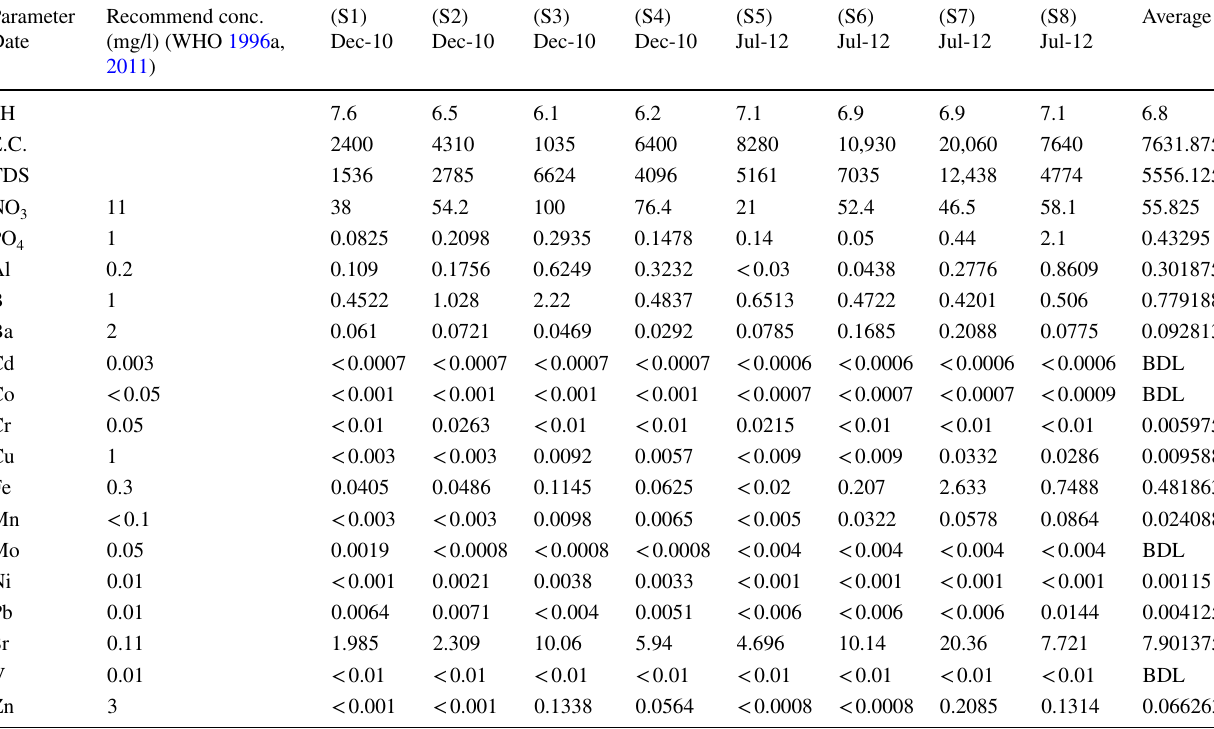
Table 8 Concentrations of heavy metals of groundwater samples from the selected eight locations in the 10th of Ramadan city expressed in mg/l. (During 2010, 2012)